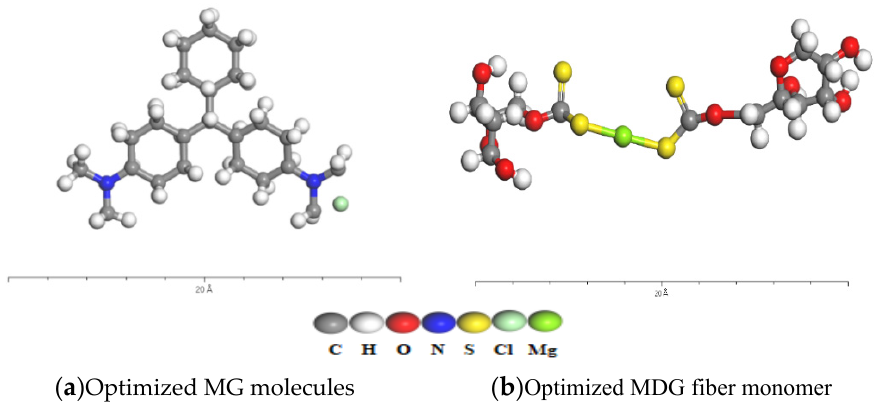
Figure 4. ( a ) MG molecules ( b ) MDG fiber optimized configuration.